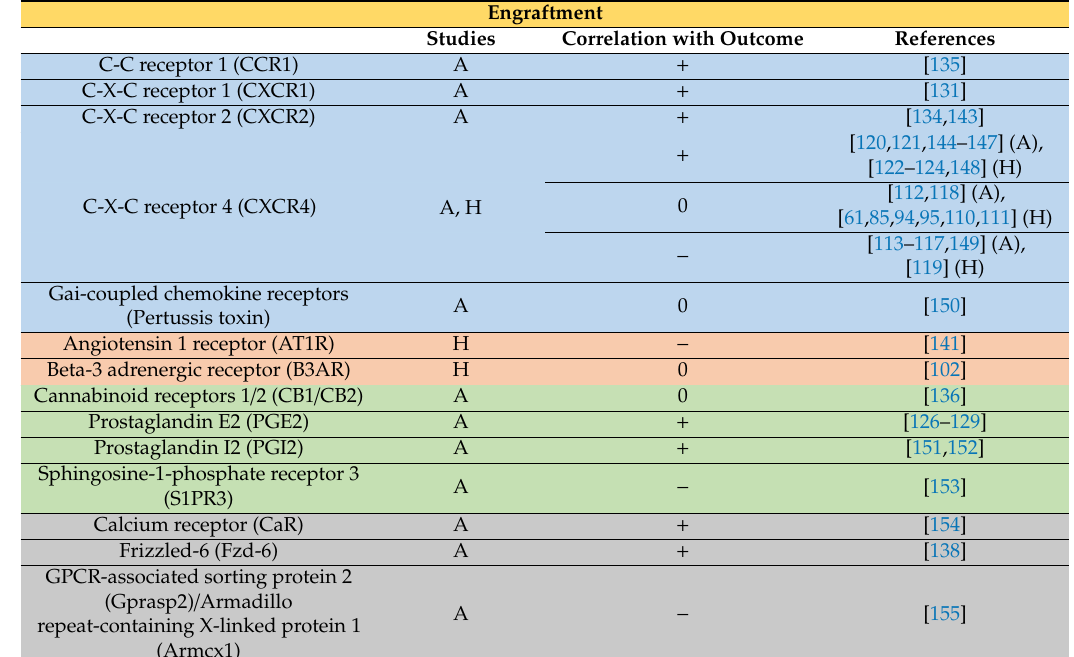
Engraftment Studies Correlation with